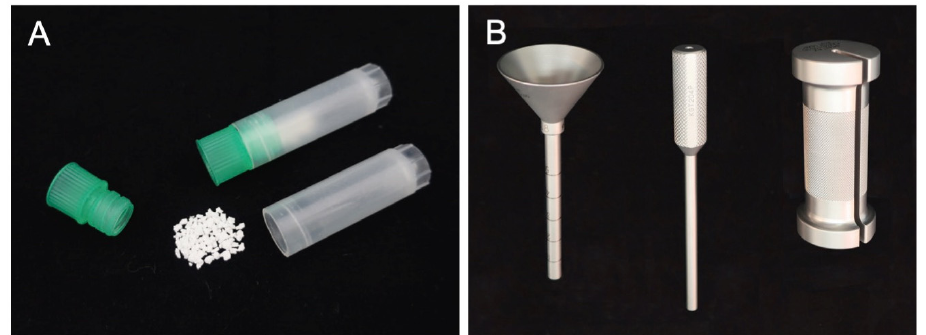
Figure 1. HA granules and the dedicated inserter for augmentation of PPS fixation. HA granules (porosity, 50%; particle size, 1–2 mm) are used for augmentation ( A ). The inserter consists of a funnel-shaped external cylinder, internal cylinder, and slide hammer ( B ).